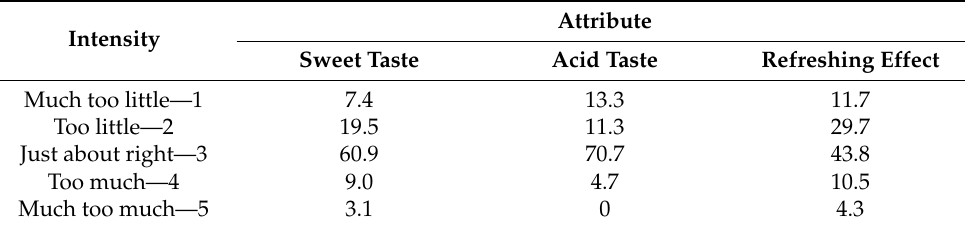
Table 4. Percentages of intensity rating of the lactose-free kefir by elderly consumers (n = 256) (Much too little—1; Much too